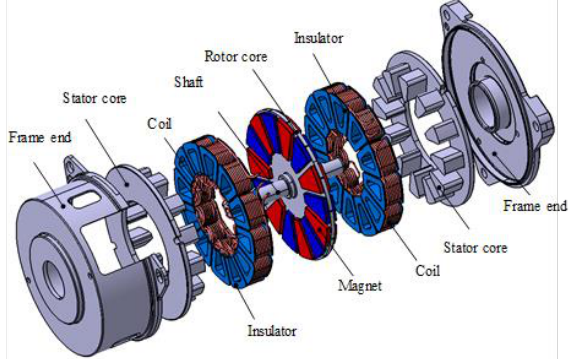
Figure 17. Structural diagram of prototype axial-gap motor.